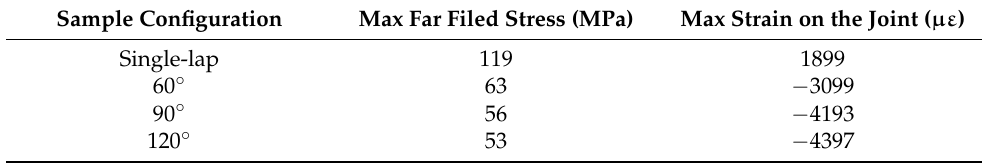
Table 1. A summary of the recorded parameters for the different joint geometries.